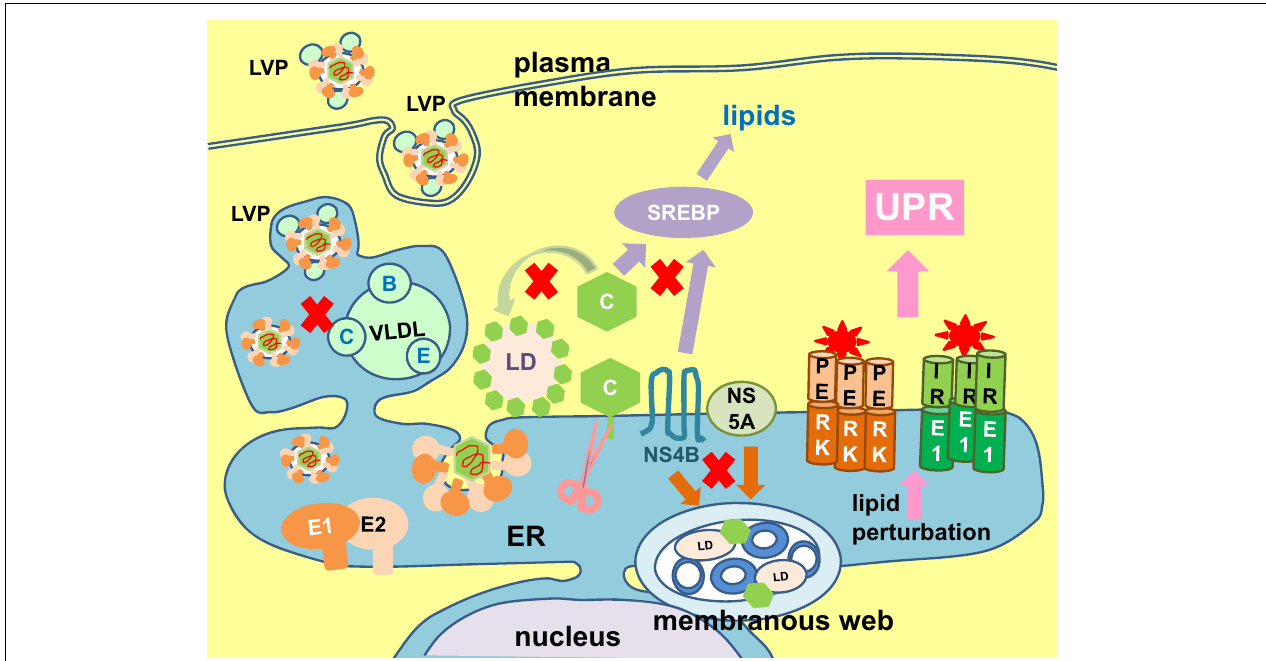
FIGURE 9 | Lipid perturbation elicits unfolded protein response. The hepatitis C virus (HCV) core protein (C) plays a part in lipid droplet (LD) formation (green arrow), and also coats the lipid droplet to initiate virion assembly and budding into the envelope proteins E1- and E2-coated endoplasmic reticulum (ER). Maturation and egress of the virion is tightly coupled to host very low density lipoprotein (VLDL) synthesis (A, apolipoprotein A; C, apolipoprotein C; E, apolipoprotein E), resulting in the